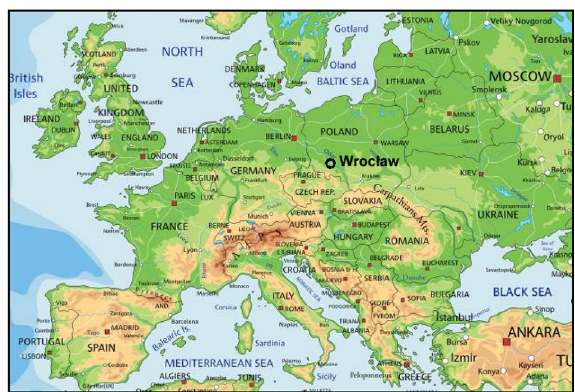
Fig. 1. The geographical position of Wrocław in